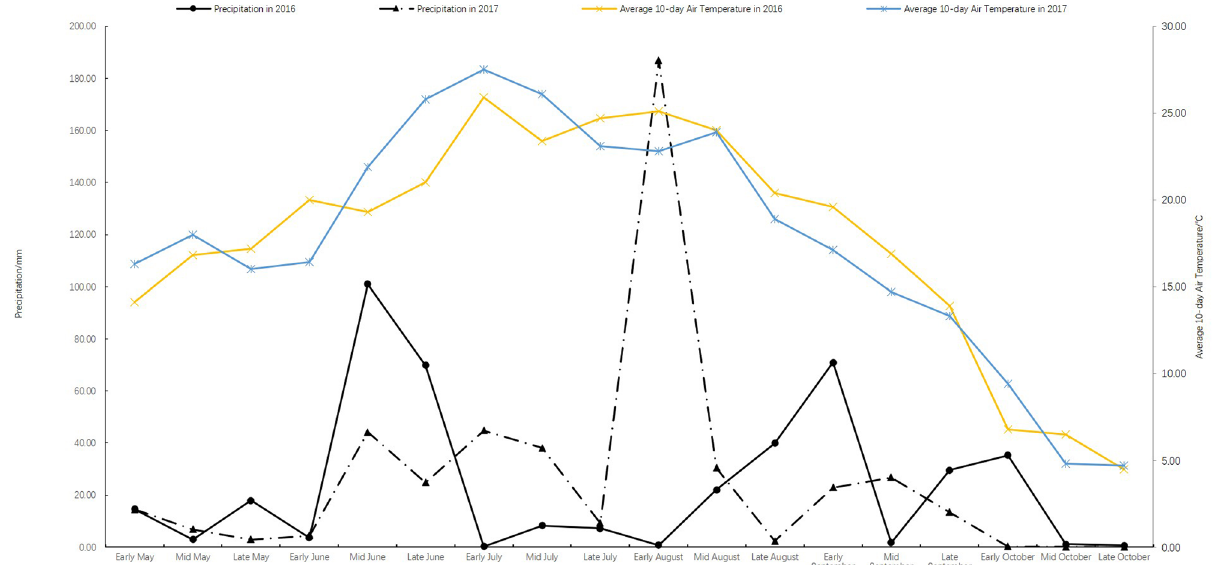
Figure 1. Precipitation and average 10-day temperature in sugar beet growth period in 2016 and 2017.